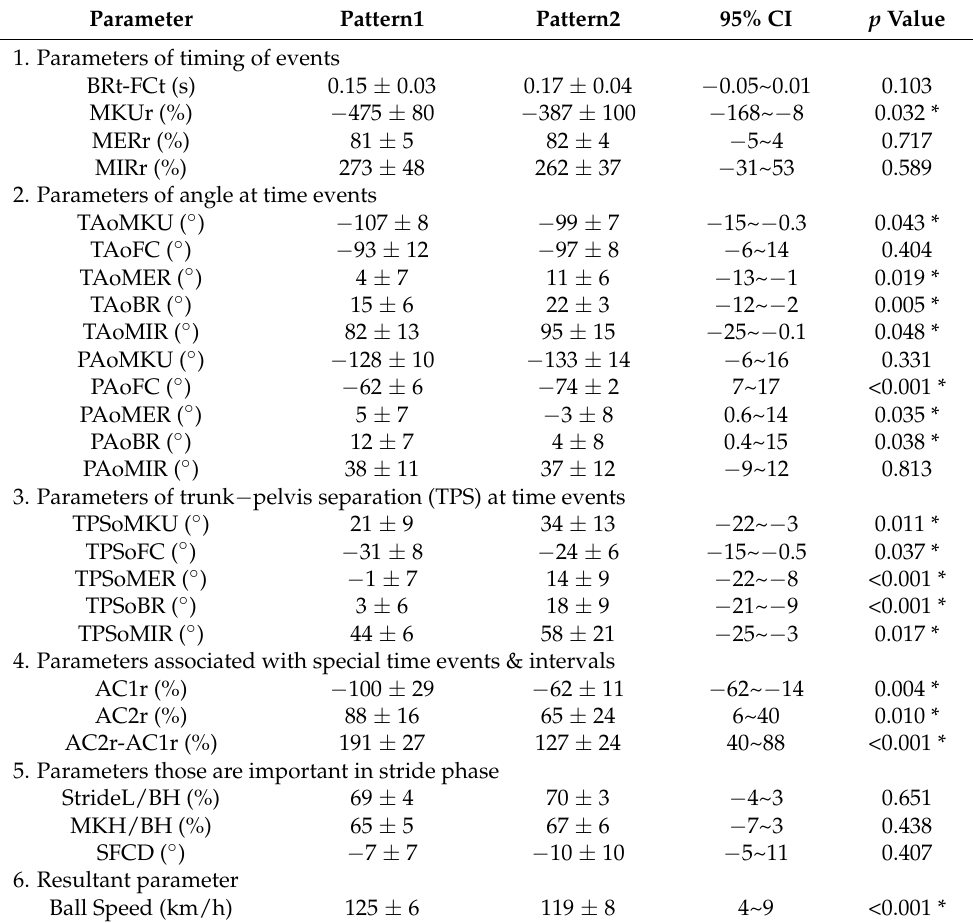
Table 3. Results of each parameter derived from the kinematic data of two groups. Parameter Pattern1